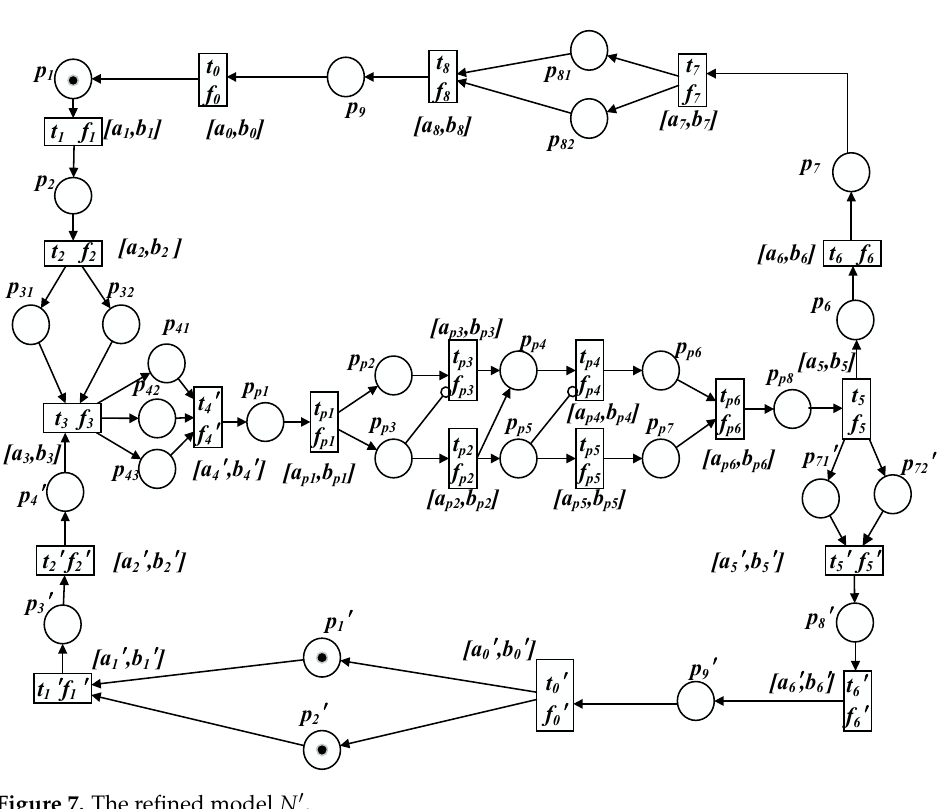
Figure 7. The refined model 𝑁′ .